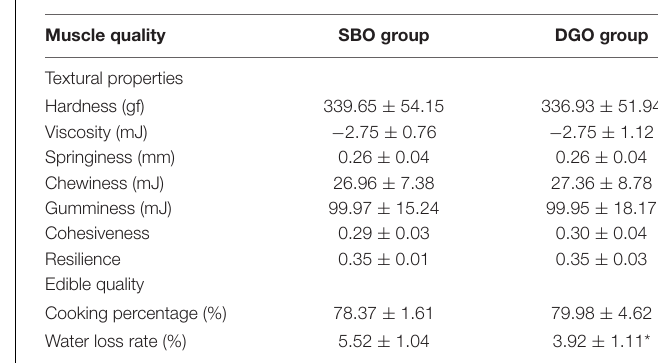
TABLE 5 | Effects of DAG-enriched oil on textural properties and edible quality in fish.